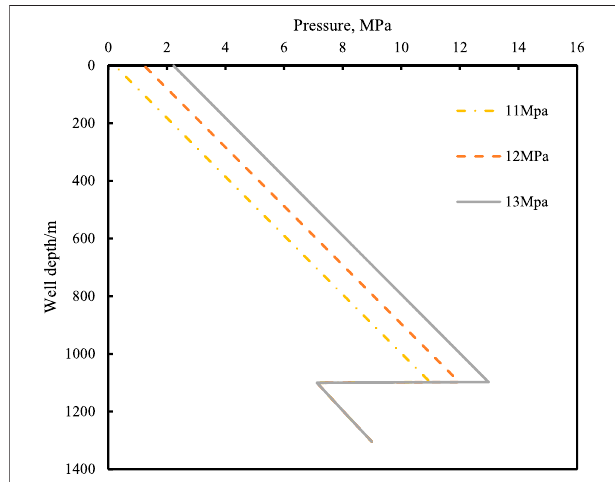
FIGURE 5 | The drainage line pressure distributions along the drainage line.